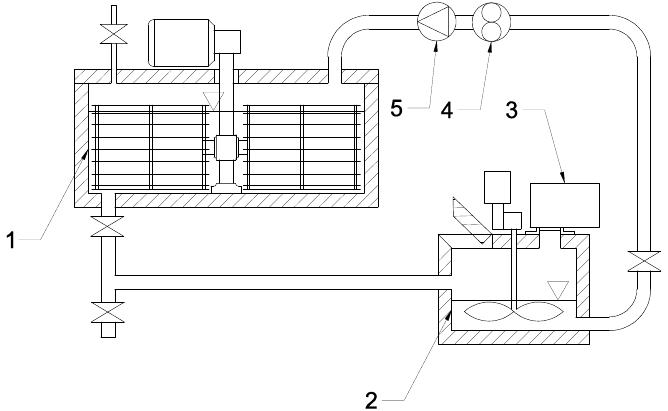
Figure 5. Scheme of the research stand. (1) Reactor with a cage mixing system; (2) intermediate tank; (3) microwave generator; (4) mill grinder; (5) displacement pump.